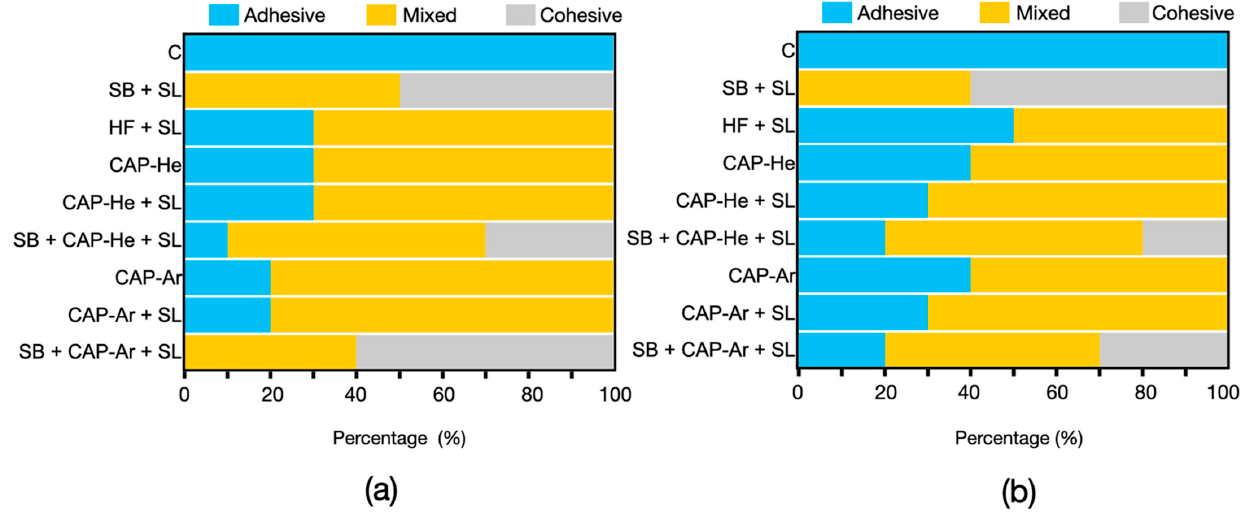
Figure 6. Failure mode distributions of shear bond test before ( a ) and after ( b )